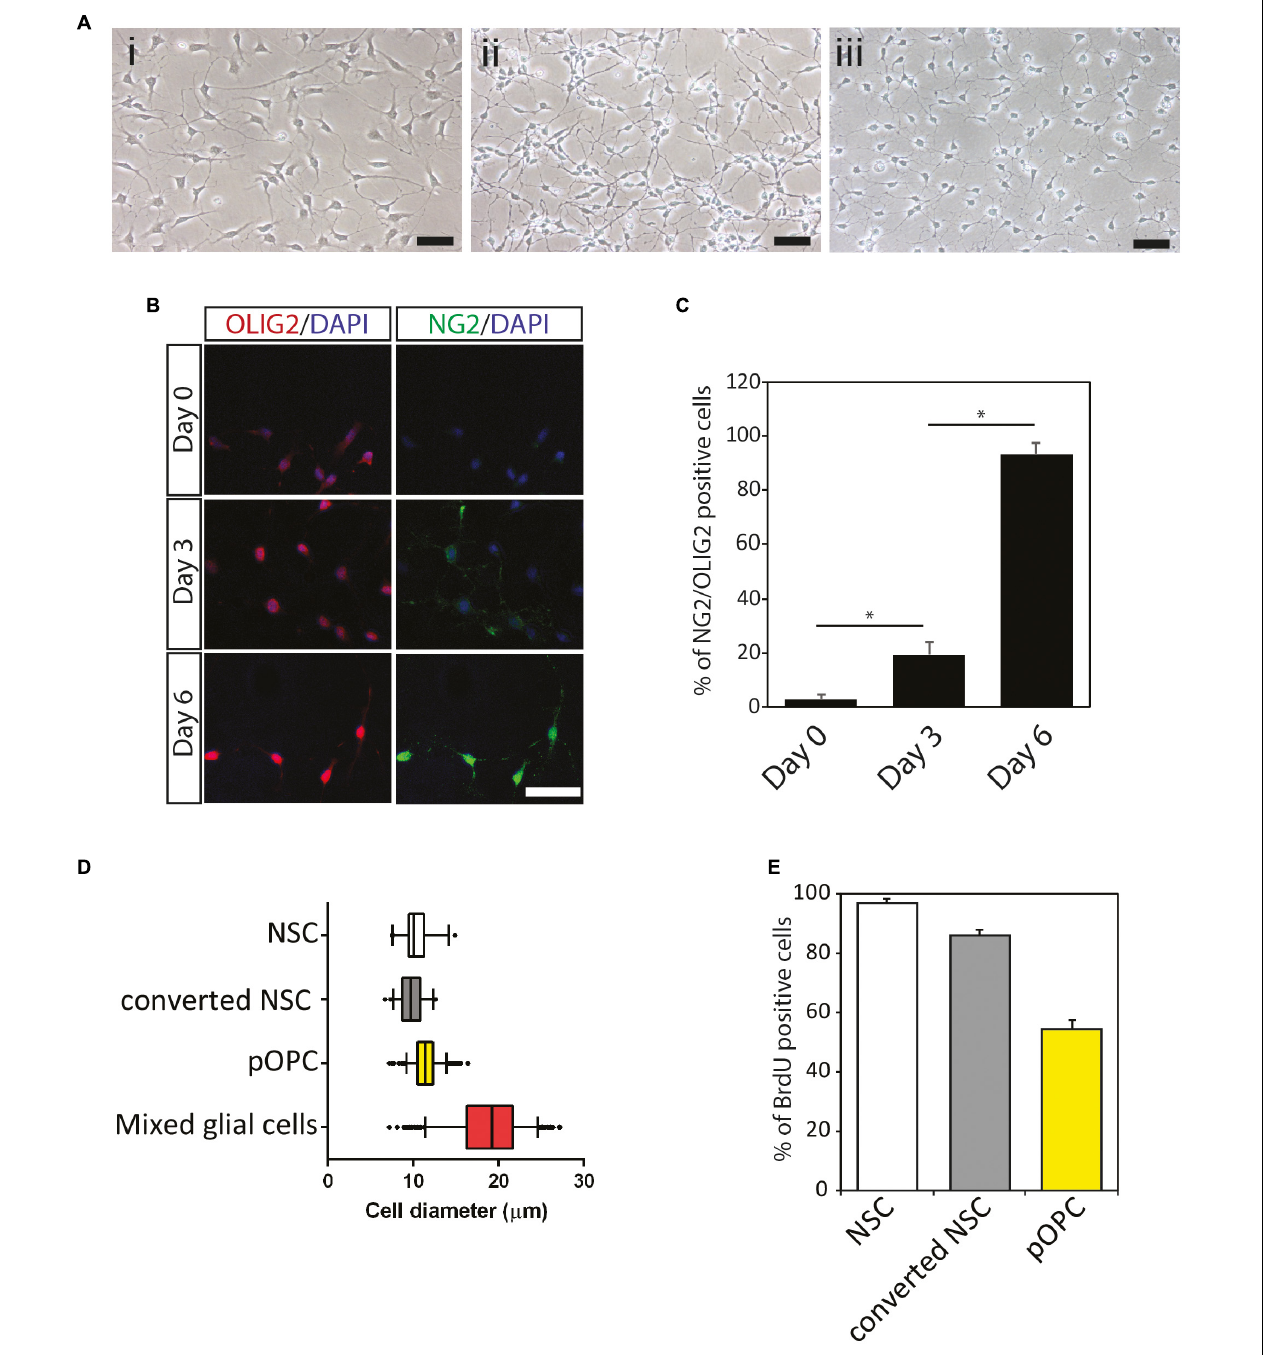
FIGURE 1 | Conversion of mouse neural stem cells to immature NG2 + /OLIG2 + progenitor cells. (A) Morphological features of mouse NSC and NSC-derived cells to immature NG2 + /OLIG2 + progenitor cells. Mouse ES cell-derived NSC (i) ; converted NSC (ii) ; primary OPC isolated from mixed glial cells (iii) . Scale bar: 50 µ m. (B) Immunocytochemical analysis of oligodendrocyte cell lineage makers NG2 and OLIG2 protein expression in converted NSC. Cells at different culture period (Day 0, 3, and 6) were stained for OLIG2 (red), NG2 (green) and Dapi (blue). Scale bar: 50 µ m. (C) Percentage of NG2 − /OLIG2 − double positive cells during conversion of NSC to OL lineage cell. Data represent means ± SD (bars) of three determinations. * P < 0.05. (D) Cell diameter quantification. Boxplots show median and confidence intervals between 5% and 95% (bars) for NSC, converted NSC, pOPC and mixed glial cells. (E) Cell proliferation analysis following 24 h BrdU incorporation. Data represent means ± SD (bars) of three determinations. * P < 0.05. n.s., not significant.